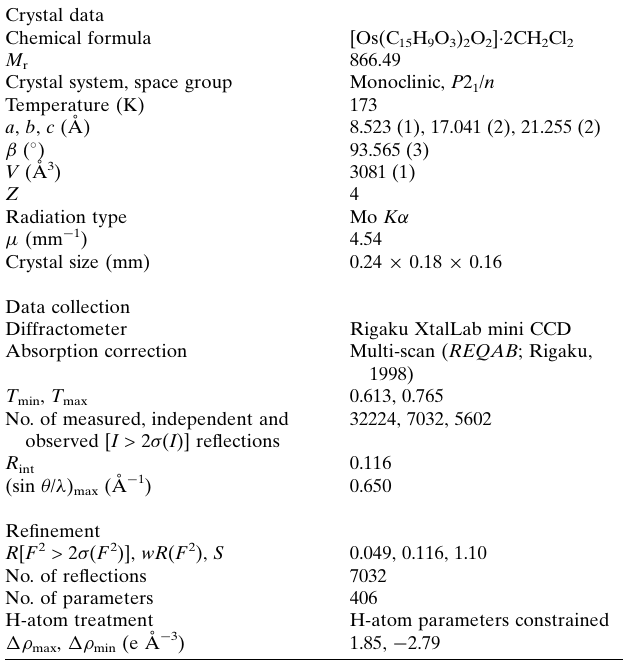
Table 1 Hydrogen-bond geometry (A˚ , (cid:3) ).